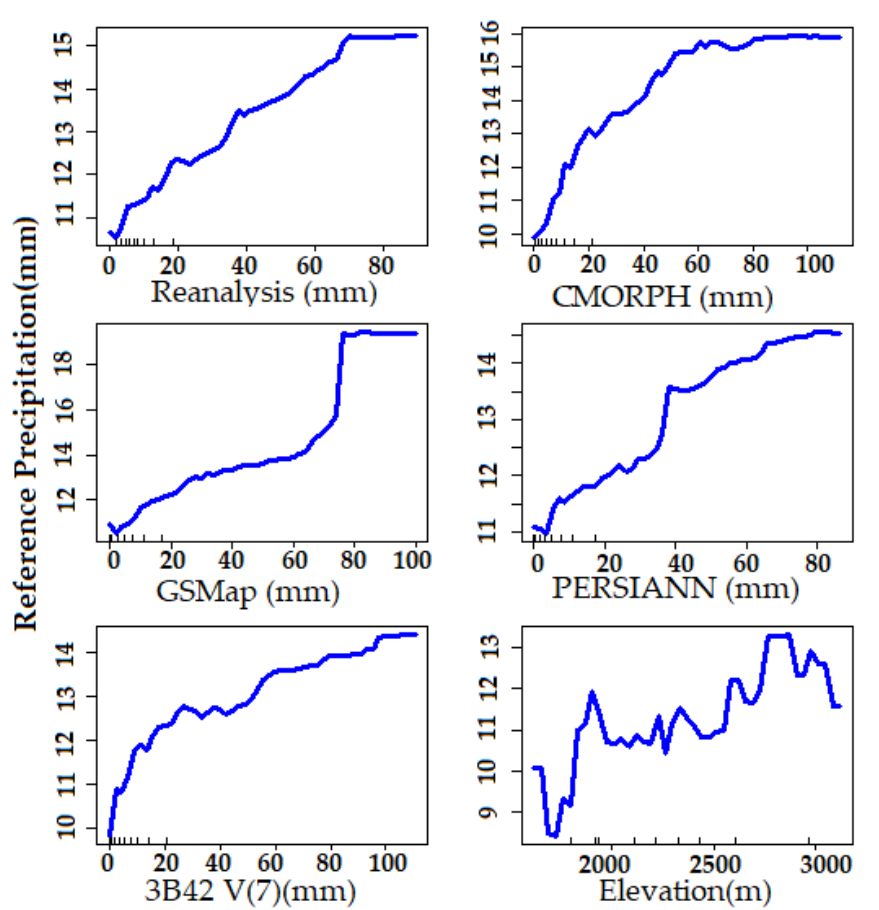
Figure 7. Relative importance of the input features for different algorithms.